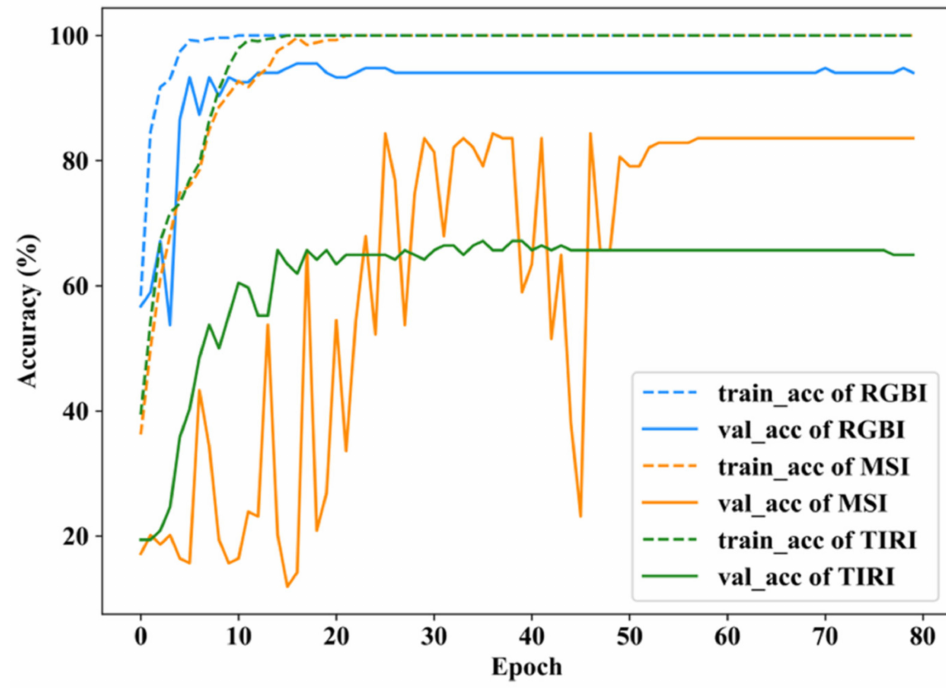
Figure 8. Performances of RGBI, MSI, and TIRI models with label smoothing in the first